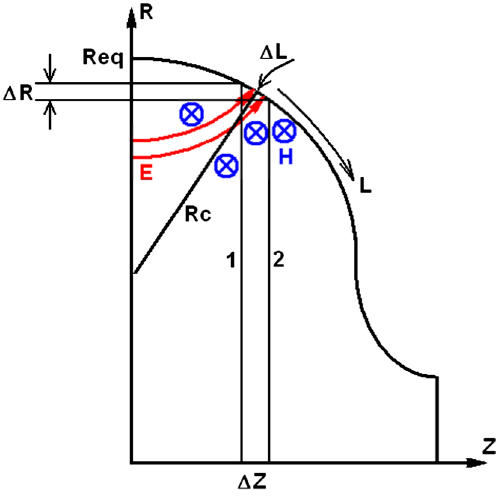
FIG. 5. Geometry for the first Maxwell ’ s